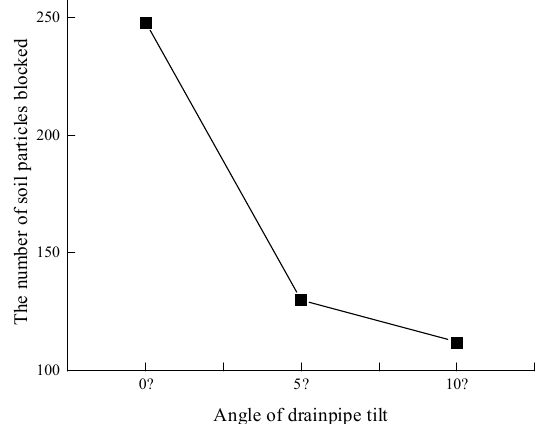
Figure 11. A statistical diagram of the number of clogged soil particles in the drainage pipe at different inclination